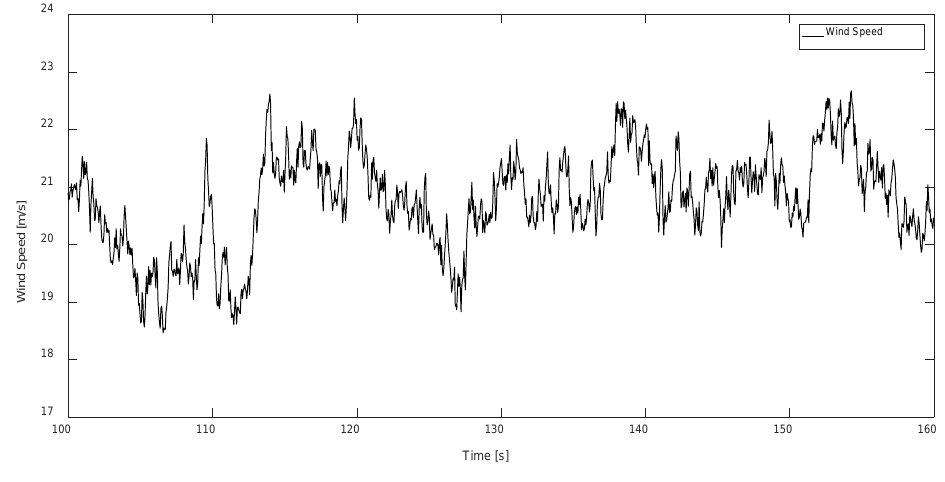
Figure 5. The hub height wind speed.